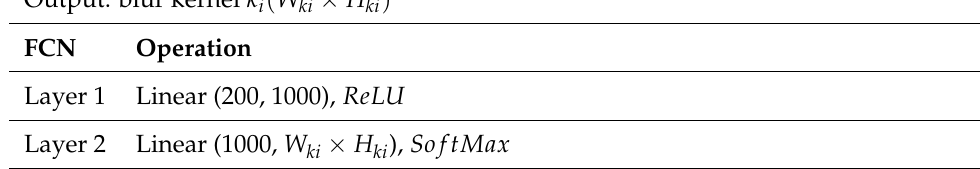
( ) . We adopt a FCN as each blur kernel estimator network f θ Table 2. The architecture f θ · ki ( ) takes a 200-dimensional input and has 1000 nodes in the W ki H ki represents blur kernel sizes. f θ × · ki hidden layer and W ki H ki nodes in the last layer. The 1D output is reshaped to a 2D blur kernel ×